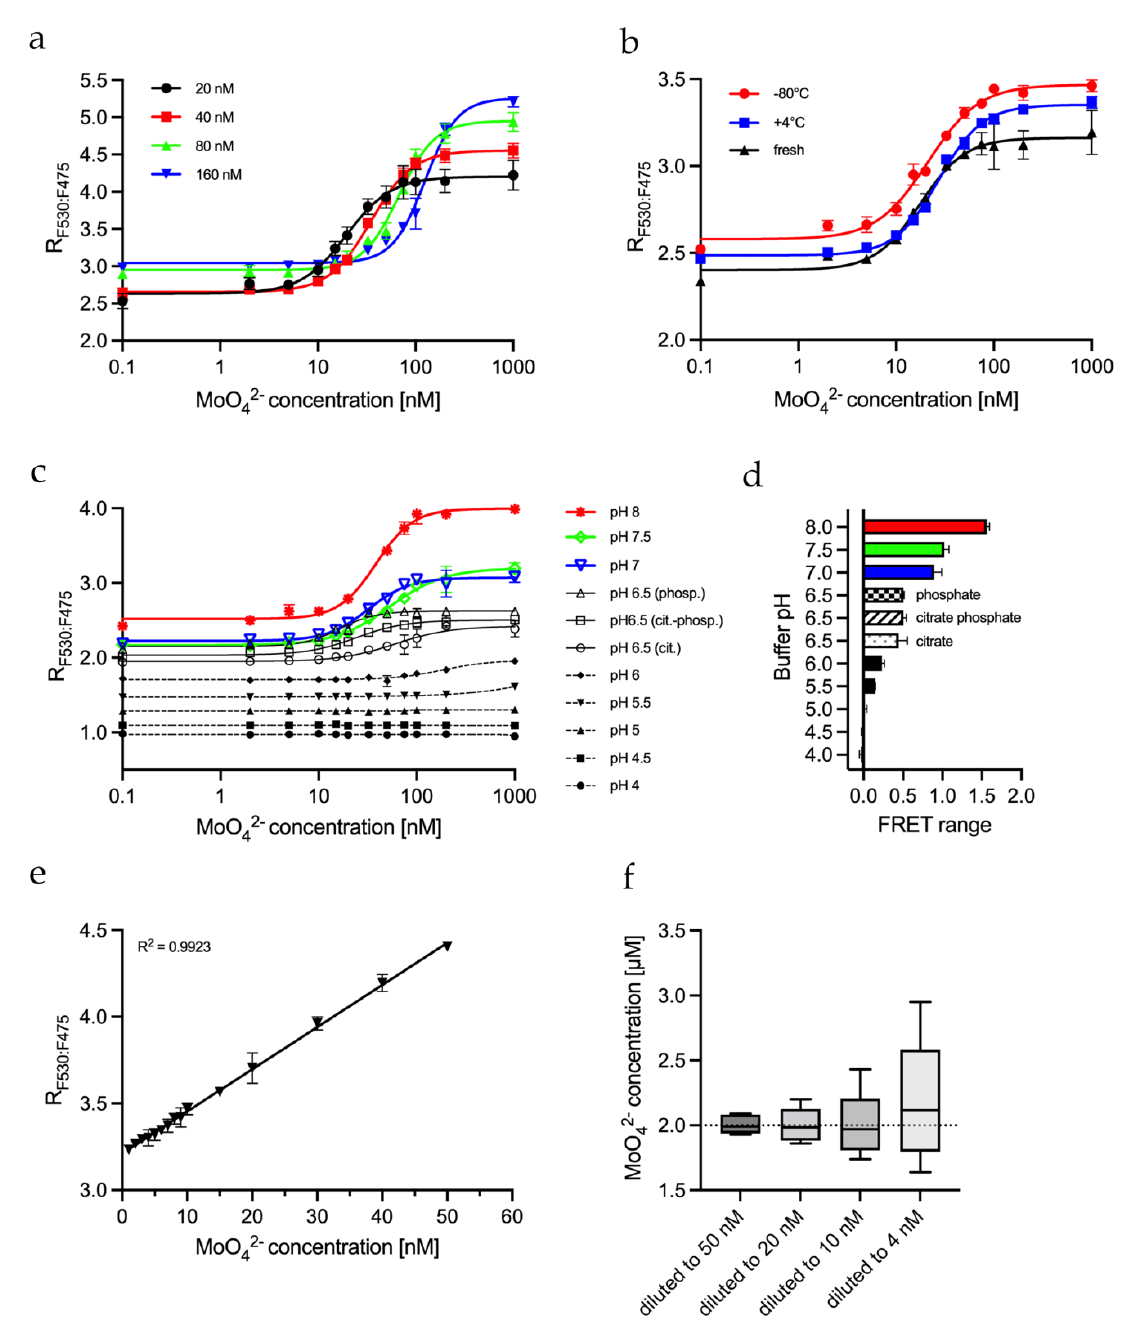
Figure 3. Characterization of MolyProbe-Strep parameters: ( a ) FRET ratio of a molybdate calibration curve analyzed with 20 nM, 40 nM, 80 nM and 160 nM MolyProbe; ( b ) Performance test of